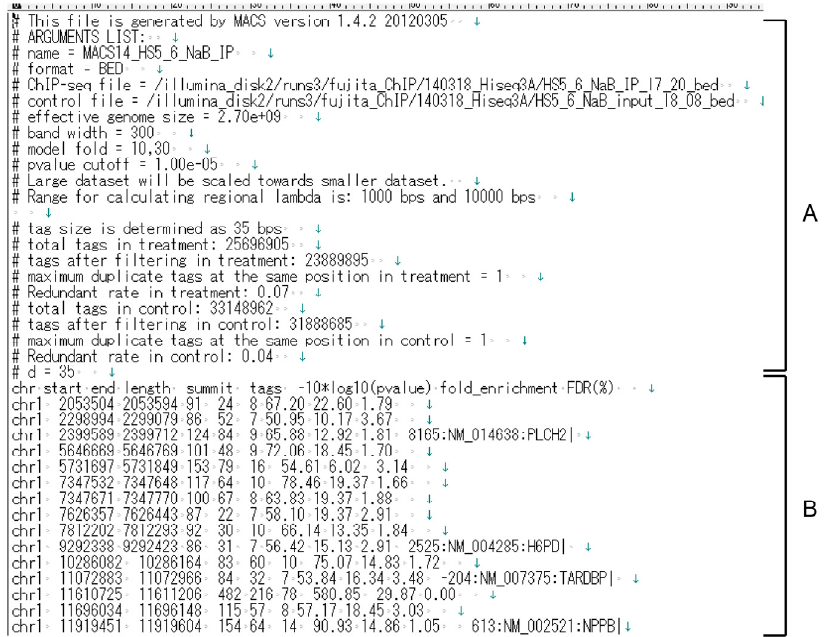
Figure 2. An example of a tab file used in enChIP-Seq analyzer. ( A ) Lines starting with # are comments and are not processed by the software. ( B ) Lines separated by tags are used for calculations in enChIP-Seq